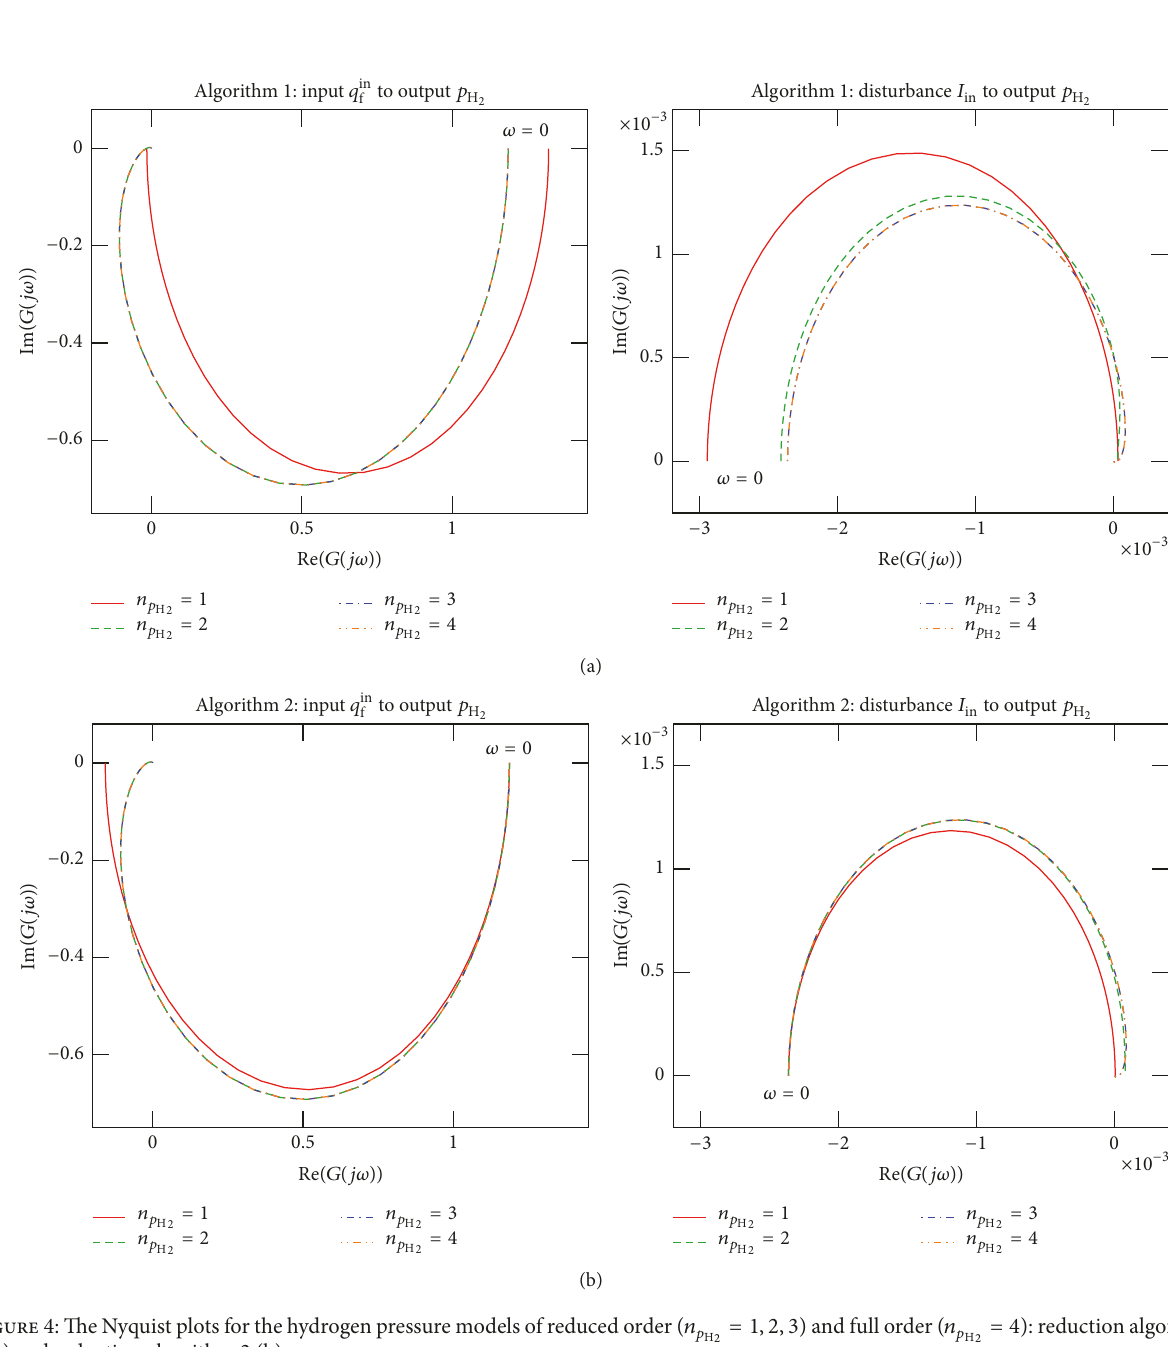
Figure 4: The Nyquist plots for the hydrogen pressure models of reduced order ( 𝑛 𝑝 1 (a) and reduction algorithm 2